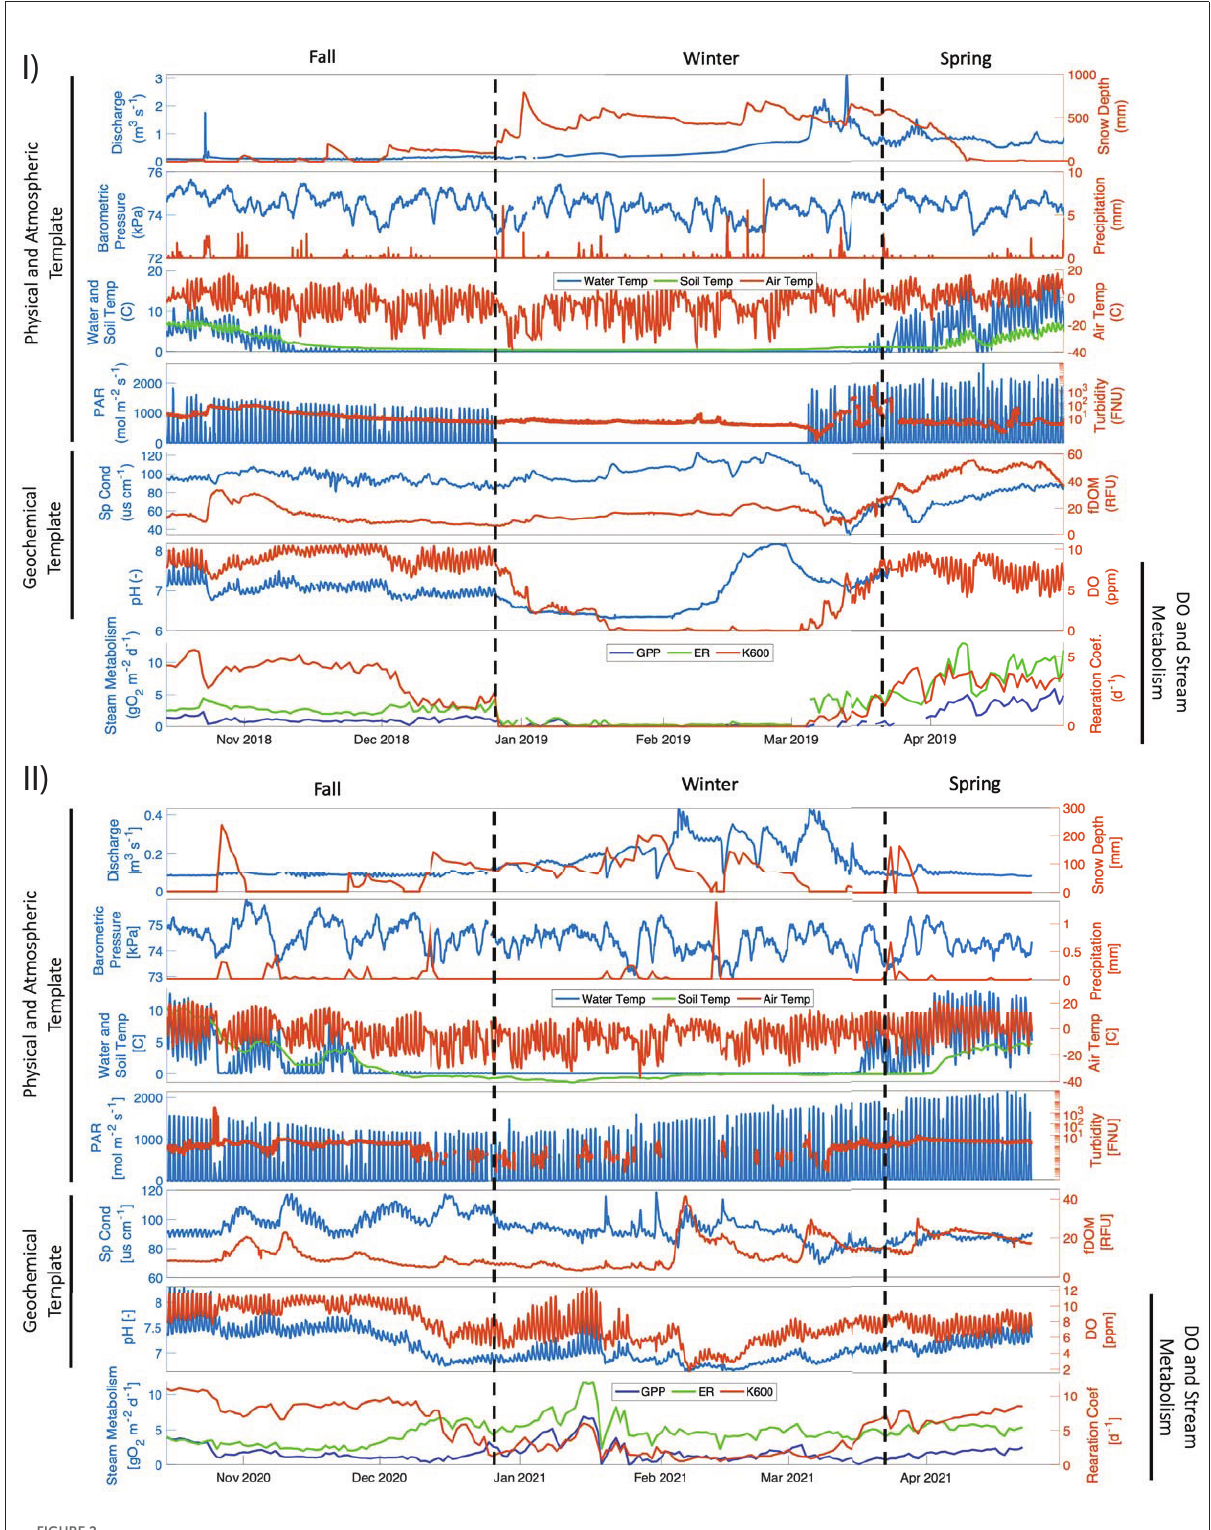
FIGURE2 Post QA/QC time series from the (I) El Niño 2018–2019 and (II) La Niña 2020–2021 data organized in three templates: physical and atmospheric, geochemical and DO and stream metabolism. Dashed vertical lines delineate fall, winter, and